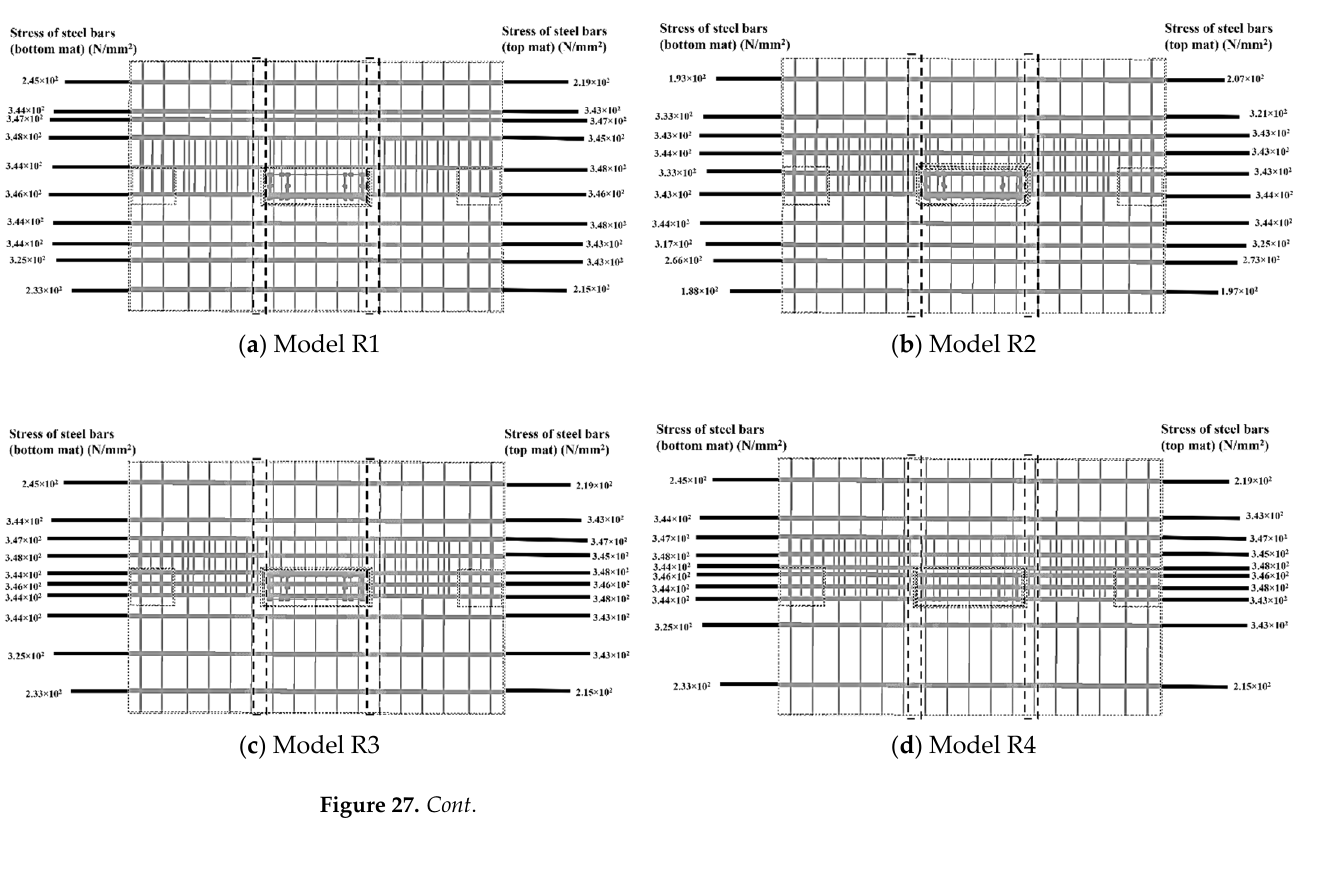
Figure 26. Lateral strength versus drift ratio curves for reinforcement distribution models.